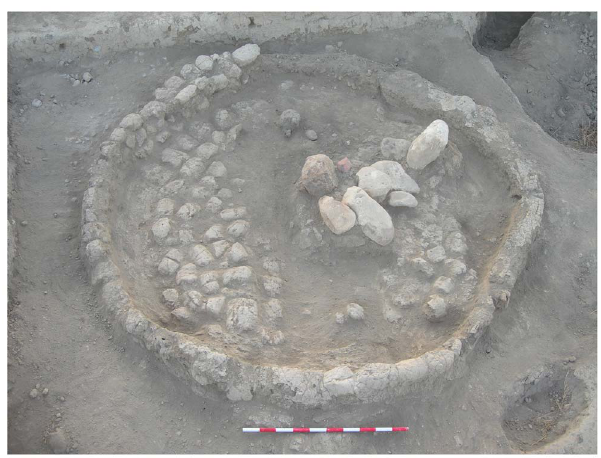
Figure 3. General view of the rounded silo, with large stones at its center. At this stage the burial had not yet been uncovered.